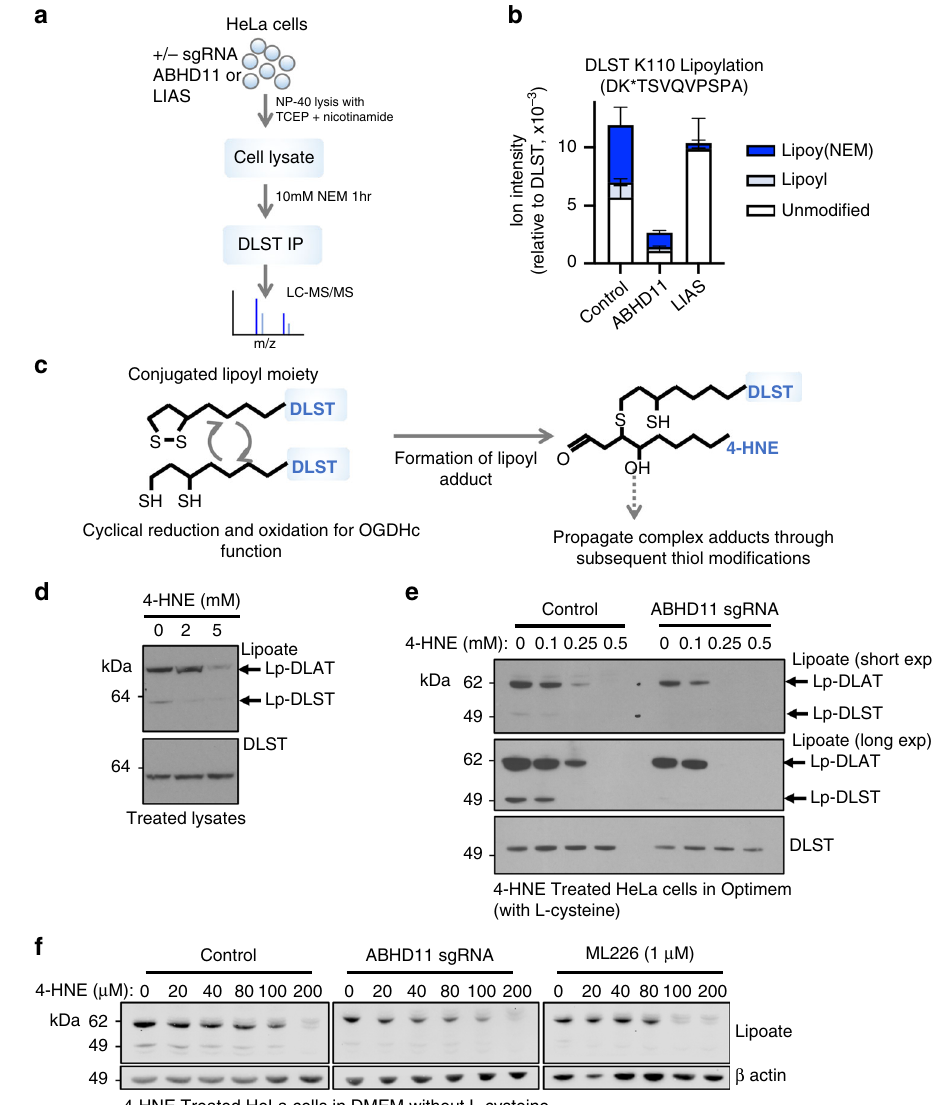
Fig. 5 ABHD11 prevents the formation of lipoyl adducts by lipid peroxidation products. a , b Mass spectrometry analysis of DLST lipoylation. DLST was immunoprecipitated from HeLa control, ABHD11 de fi cient or LIAS de fi cient cells, and treated with NEM to modify the free thiols and maintain the lipoyl moiety in a reduced state. After SDS-PAGE, protein samples were digested with Asp-N protease and analysed by LC-MS/MS. b Normalised level of lipoylated DLST peptide compared to DLST reference peptide. Relative levels of the unmodi fi ed, NEM-dihydrolipoamide, and lipoamide DLST peptide are shown. n = 3, Mean± SEM. c Schematic of normal cyclical reduction and oxidation of the lipoyl moiety on DLST (left). The reduced dihydrolipoamide can react with lipid peroxidation products (e.g., 4-HNE) to form lipoyl adducts through the free thiols, which may also propagate (right). d – f Effect of 4-HNE treatment on lipoylation. HeLa cells lysates were treated with 4-HNE at the indicated concentrations for 60 min (50 °C) and immunoblotted for lipoylated proteins or total DLST ( d ). Control or ABHD11 de fi cient HeLa cells were treated with 4-HNE in serum-free Optimem ( e ) or serum and L-cysteine free DMEM ( f ) for 90 min (37 °C), lysed and immunoblotted for lipoylation and total DLST.